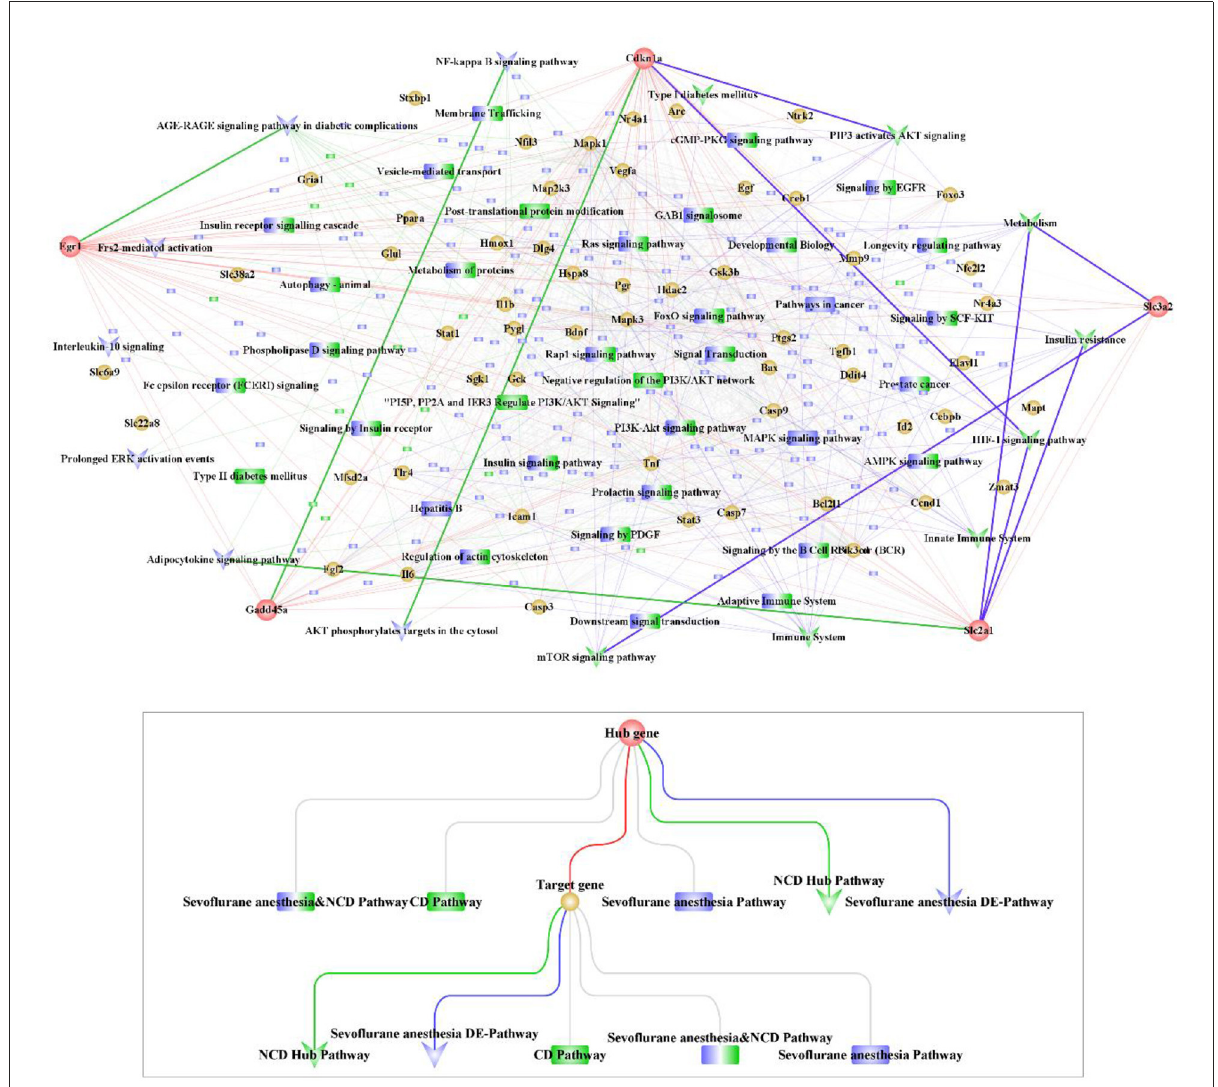
FIGURE8 Hub cross talk gene-Target gene-pathway network analysis. The network contains 281 nodes and 1,328 edges, including 5 hub cross talk genes, 55 Target genes, 160 Sevoflurane anesthesia Pathway, 18 NCD Pathway, 28 Sevoflurane anesthesia & NCD Pathway, 8 NCD hub Pathway and 7 Sevoflurane anesthesia